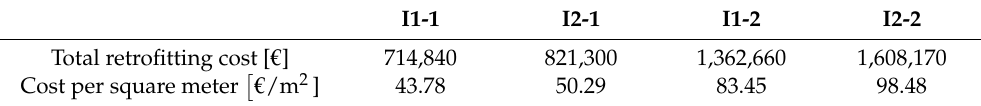
Table 17. Summary of the financial costs of each intervention. I1-1 I2-1 I1-2 I2-2 Total retrofitting cost [ € ] 714,840 821,300 1,362,660 1,608,170 (cid:2) € Cost per square meter /m 2 ] 43.78 50.29 83.45